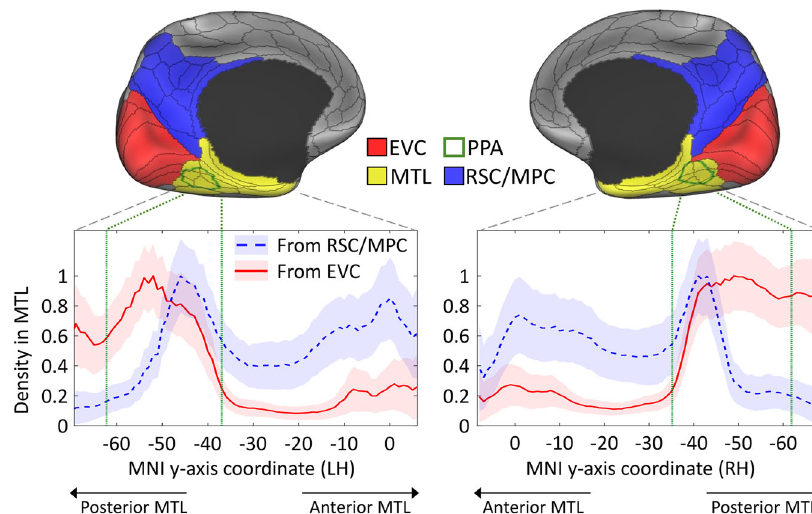
Fig. 1 Density of tractography projections from medial occipital and parietal regions to the medial temporal lobe. The upper panel shows the three large ROIs used to select streamlines between the medial temporal lobe (MTL) on one end, and early visual cortex (EVC), medial parietal cortex (MPC), and retrosplenial complex (RSC) on the other end. The parahippocampal place area (PPA), which is located in the posterior MTL, is also delineated with a green contour. The plots in the lower panel represent the mean density of streamline terminations in the left and right MTL according to its longitudinal y -axis. Projections from both EVC (red lines) or the RSC/MPC (blue dashed lines) are displayed as the mean and standard deviation (shaded areas) across 200 subjects. While the EVC connections show a strong preference for the posterior MTL, especially the parahippocampal place area (PPA), the RSC/MPC connections show posterior and anterior peaks. Within the PPA, the anterior portion receives high density projections from both ROIs, while the posterior portion receives projection preferentially from EVC. The PPA ’ s most posterior and anterior coordinates are indicated with the vertical green lines within the plots. Coordinates correspond to the MNI template. The main ROIs are based on the MMP atlas shown as black contours 68 , and the PPA is based on 48